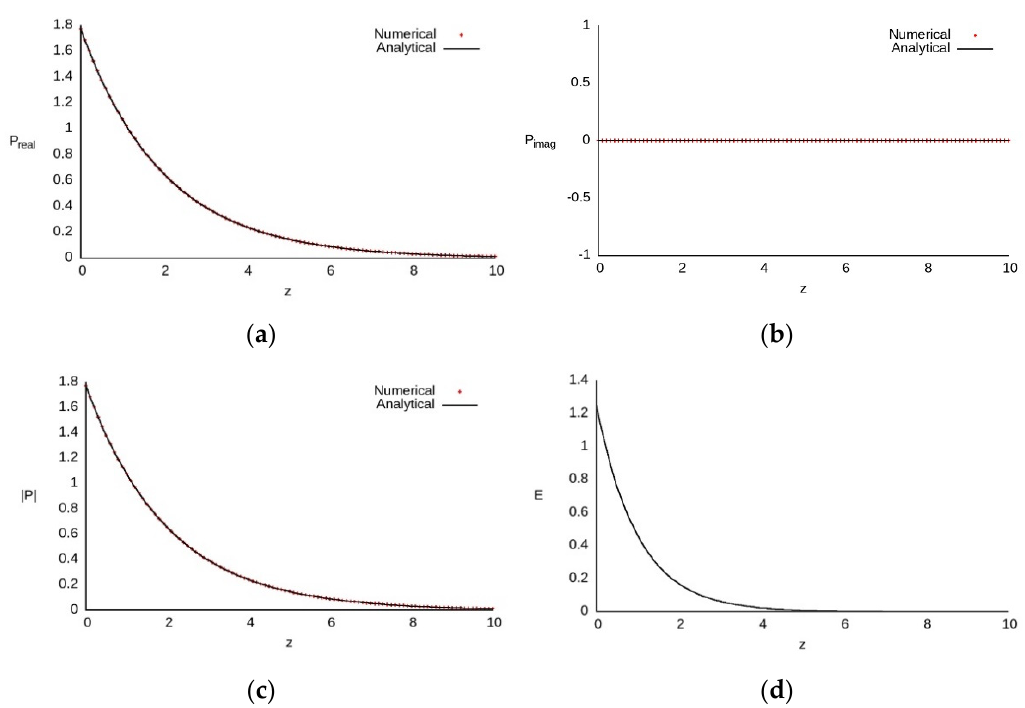
Figure 3. The function P ( z , L t ) (4c) evolution: real part ( a ), imaginary part ( b ), its modulus ( c ), and the pulse’s energy ( d ) obtained via computer simulation (red dotted line) and analytical solution (black solid line) with the parameters D 2 ω = 0, δ 0 = 1, n 0 = 0.